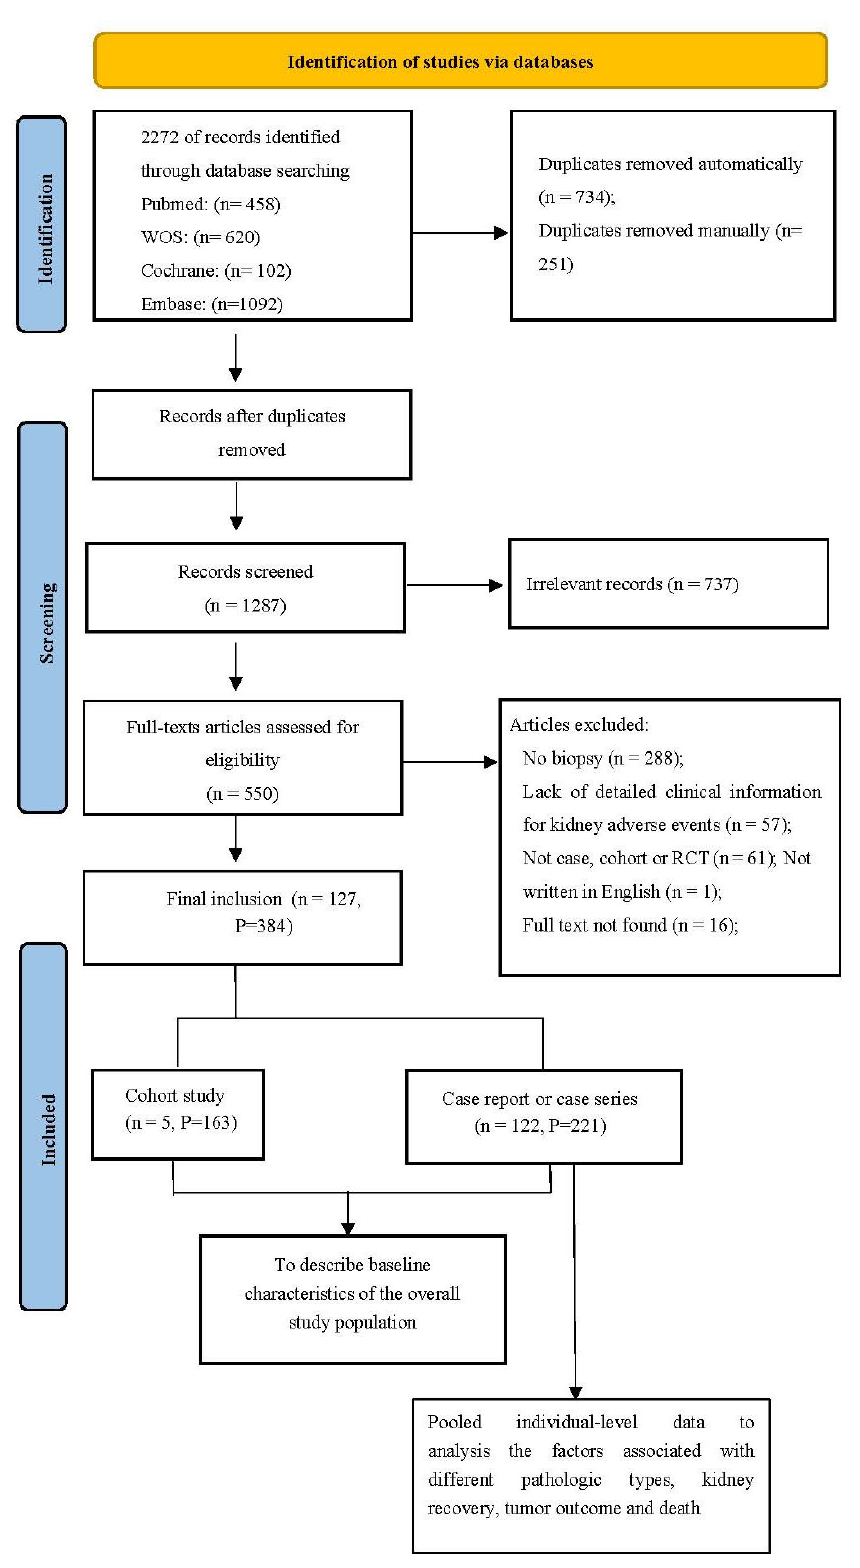
Figure 1. PRISMA 2009 Flow Diagram. “n” represents the number of studies; “P” represents pa ‐ tients.